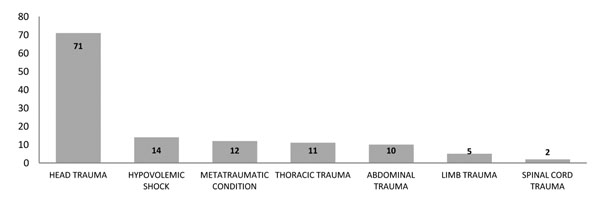
Causes of death of casualties with ISS 9-24.